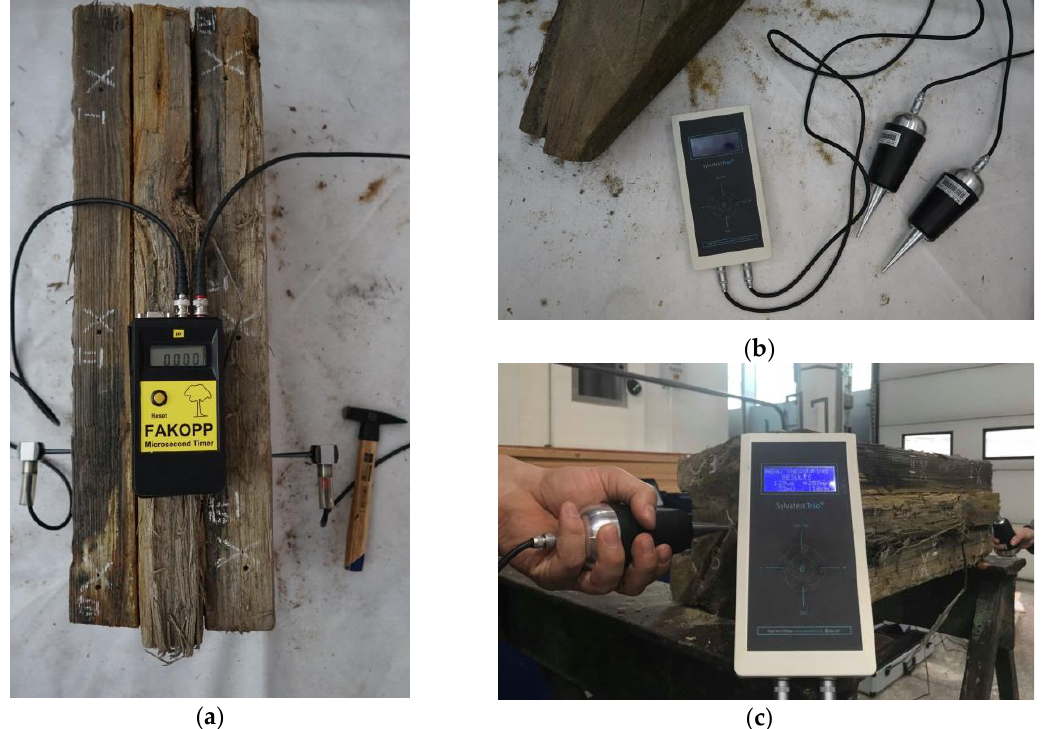
Figure 2. Devices for testing by acoustic method: ( a ) Fakopp Microsecond Timer using stress wave; ( b ) Sylvatest Trio device using ultrasonic wave; ( c ) Sylvatest Trio device during test.